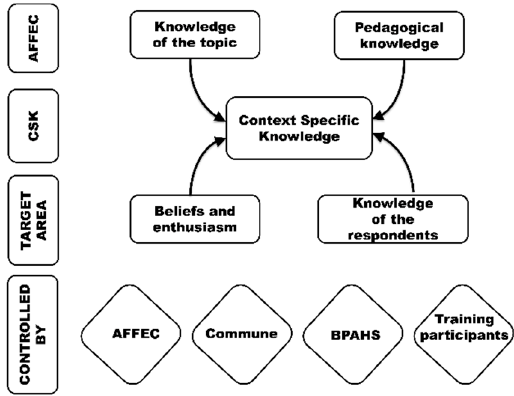
Figure 1. The Set for Facilitators and their Quality Involvement.